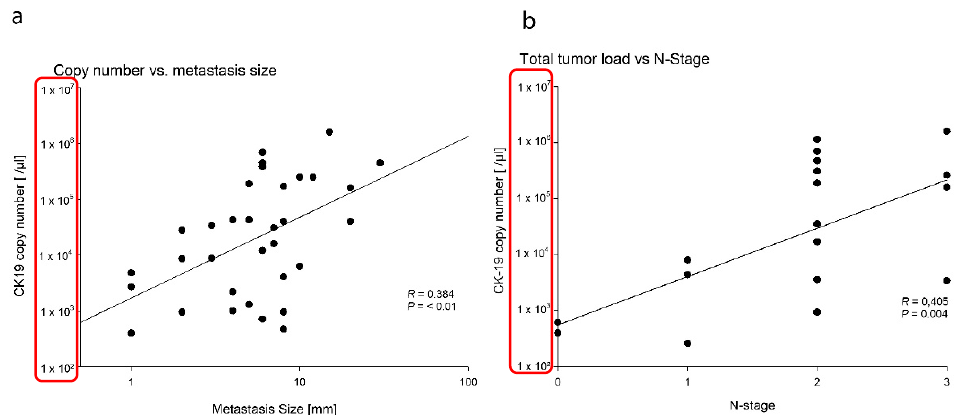
Figure 4. ( a ) Correlation between copy number/µL and matastasis diameter. ( b ) Correlation between total tumor load and N-stage.